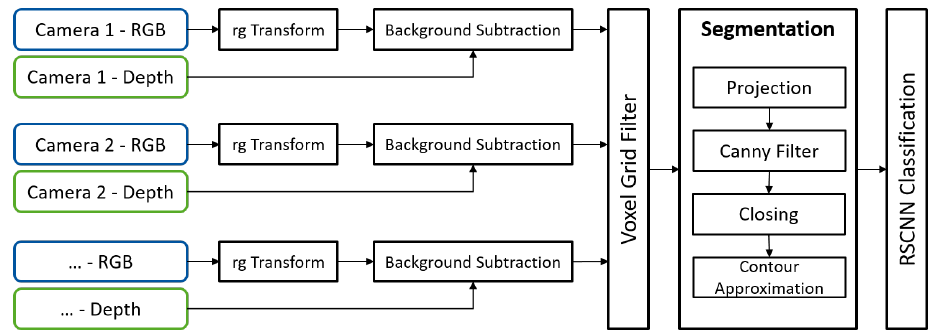
Figure 1. Methods used and data flow in the proposed